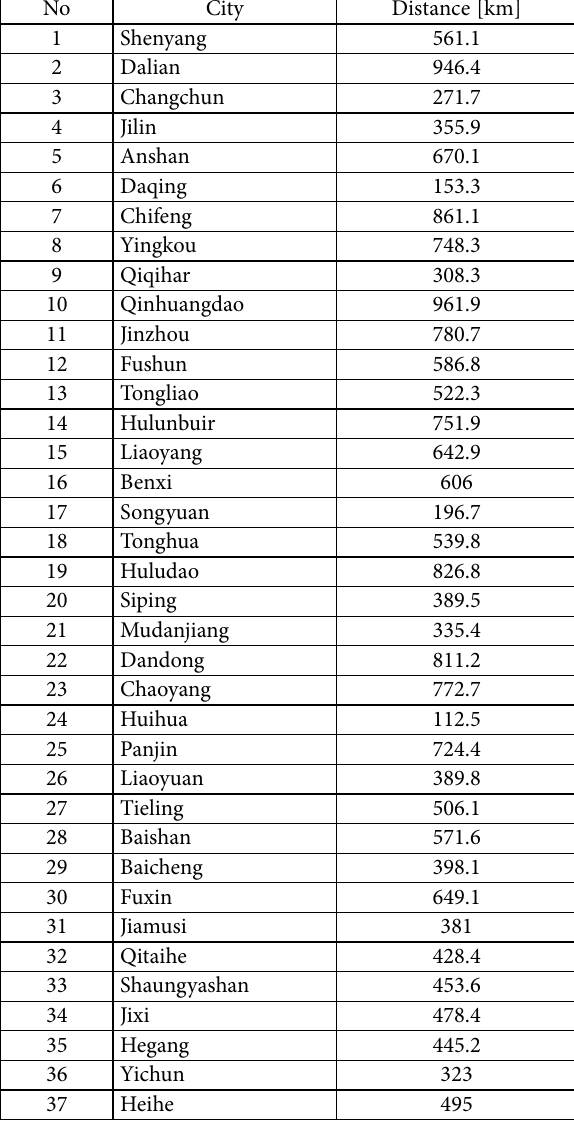
Table A1. The mileage between Harbin and other